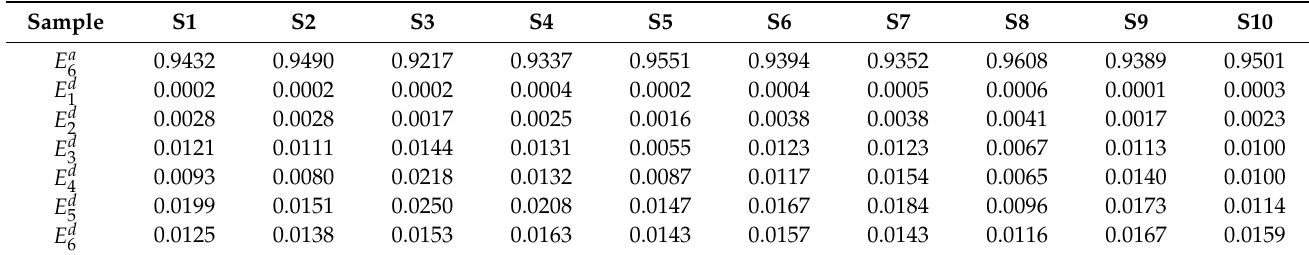
Table 3. Energy eigenvector of flow turbulence acoustic signal.